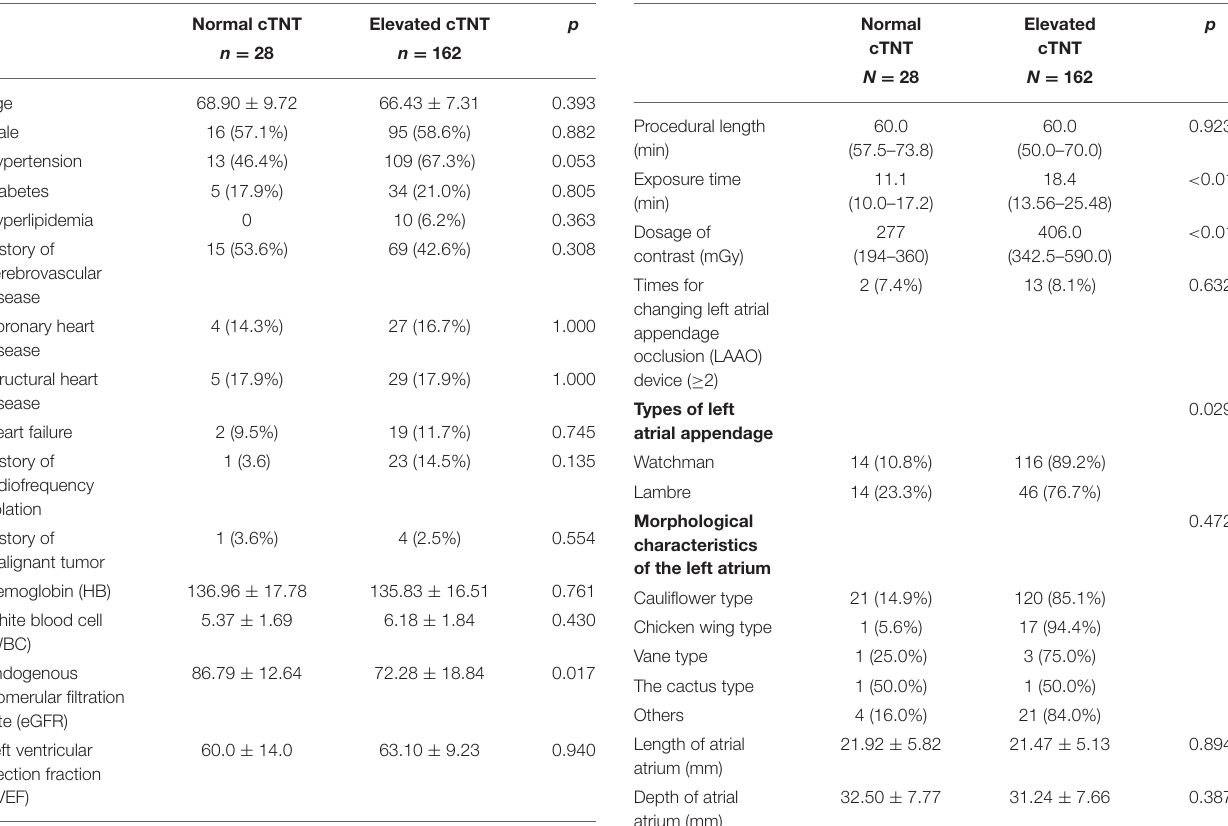
TABLE 1 | Baseline characteristics between the normal cardiac troponin T (cTNT) and elevated cTNT groups.